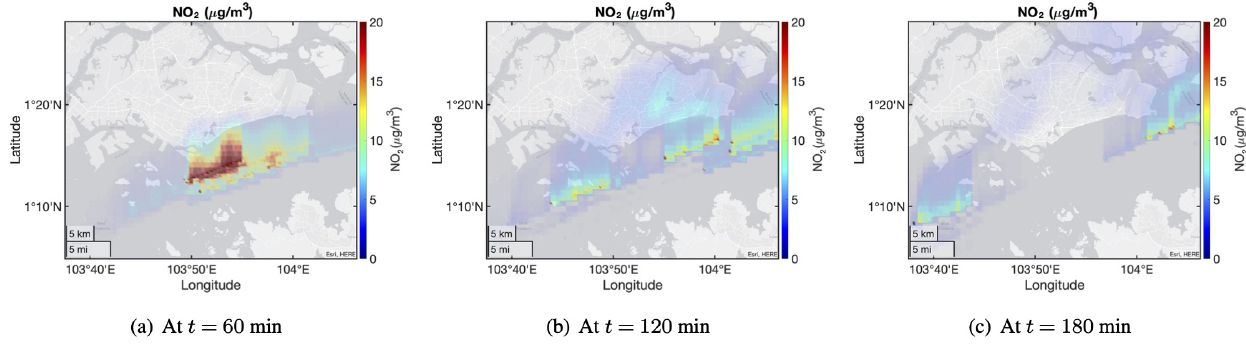
Figure 13. Instantaneous NO 2 concentrations near the ground by using the LS model (case 2).